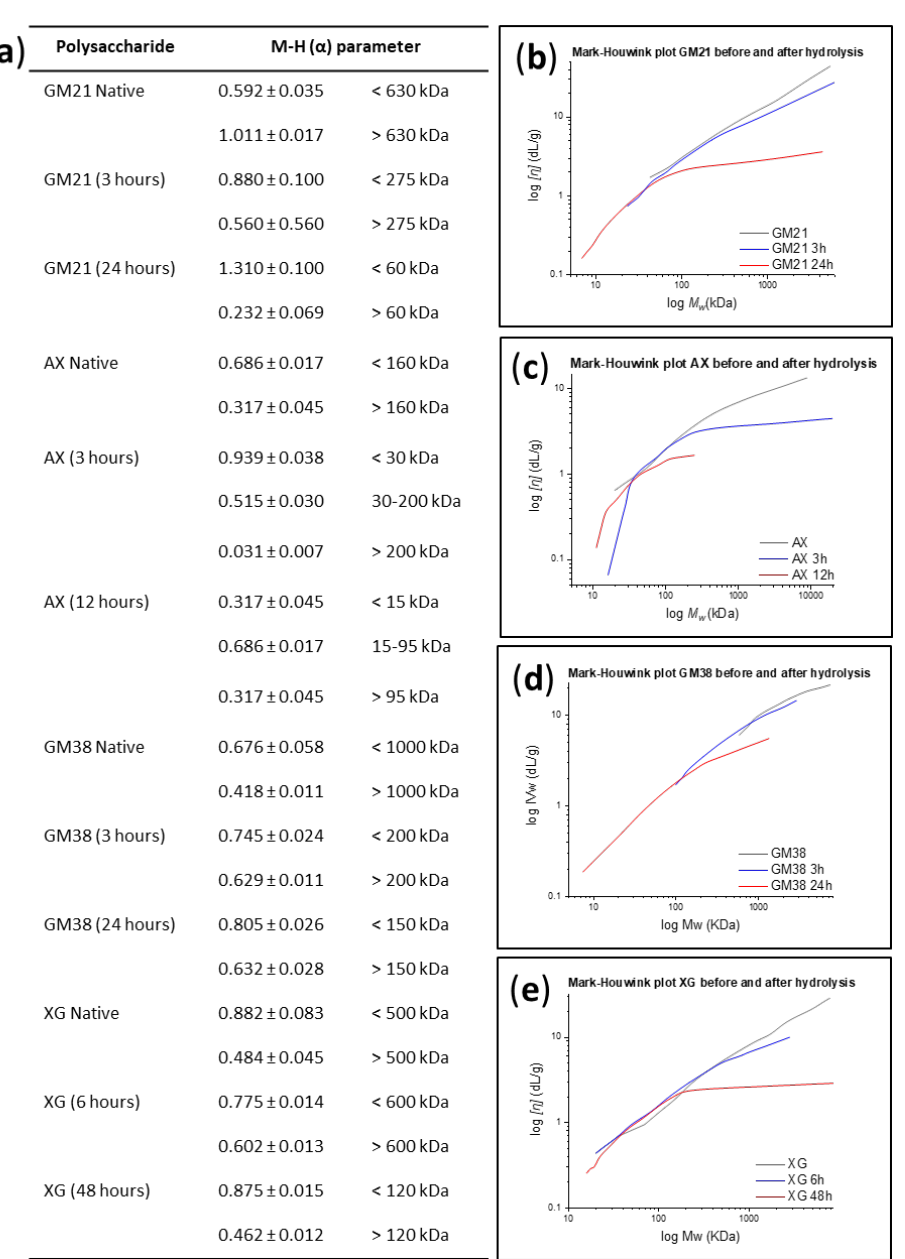
Figure 4. ( a ) Mark-Houwink α values of polysaccharides before and after partial hydrolysis. Mark-Houwink-Sakurada plots, namely the variation in intrinsic viscosity ([ η ]) as a function of weight average M w of ( b ) guar galactomannan (GM21), ( c ) wheat arabinoxylan (AX), ( d ) guar galactomannan (GM38), and ( e ) tamarind xyloglucan (XG) before and after partial acid hydrolysis (3, 12, or 24 h). The data were acquired by SEC-RID-LALS/RALS-IV using 0.1% polysaccharide in aqueous 0.1 M NaNO 3 + 0.02% NaN 3 solution.